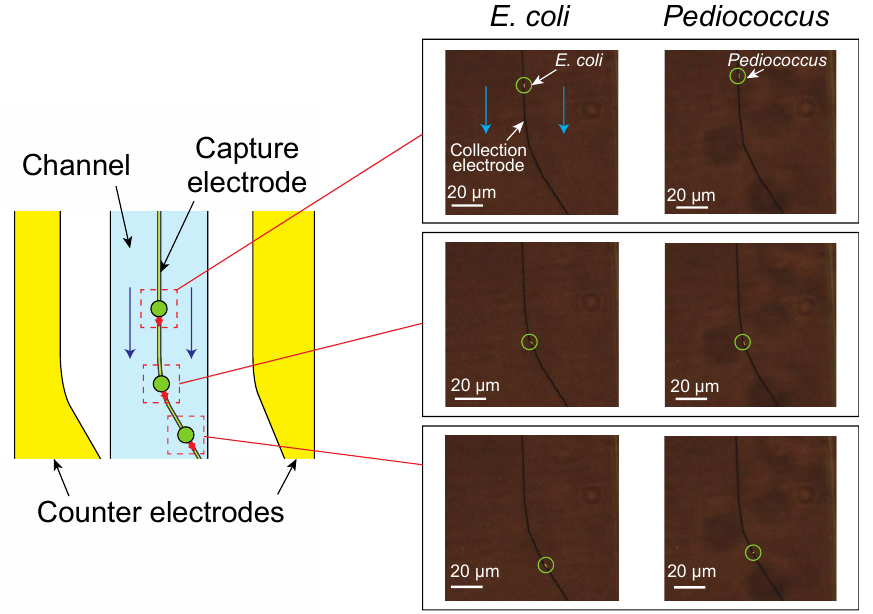
Figure 9. Off-axis manipulation of the bacteria: the bacteria move along the electrode in a direction oblique to the flow.